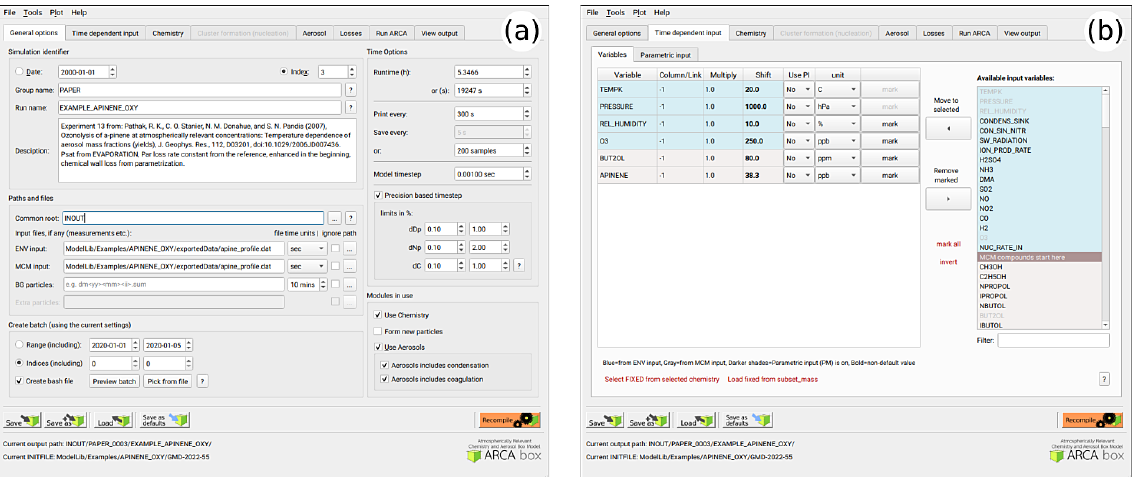
Figure 6. Screenshots of the GUI showing the tabs “general input” (a) and “time-dependent input” (b) , where the model input concentrations and environmental variables are defined along with their sources and units. The settings shown here are from the simulation shown in Fig. 11.